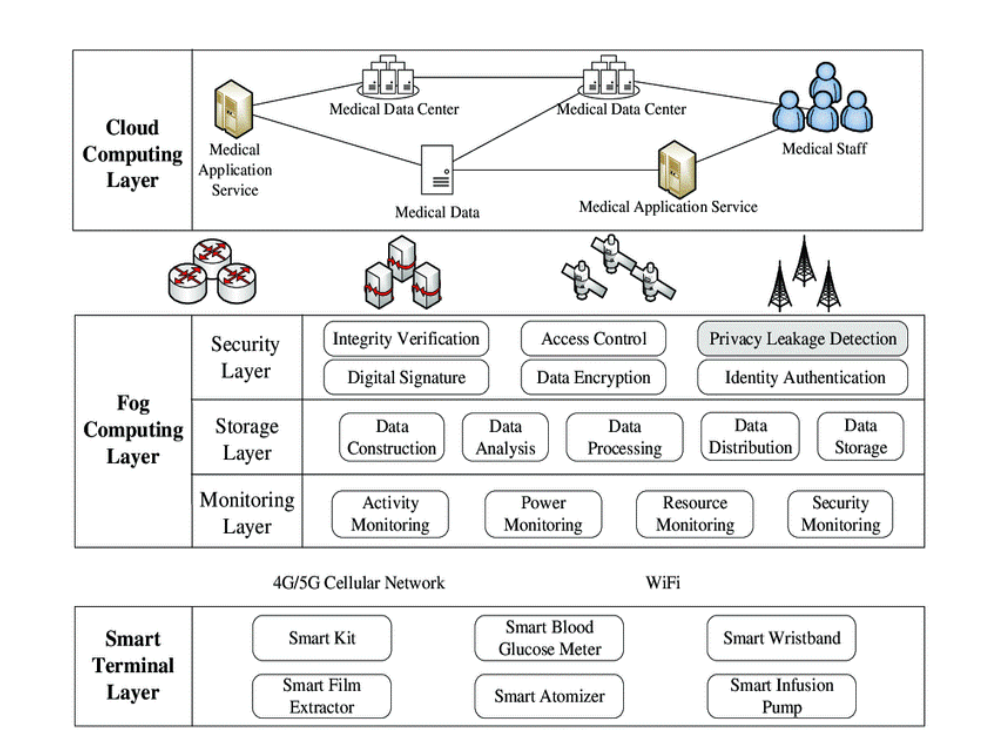
Figure 3. A three-layered Fog Computing network architecture with 5G